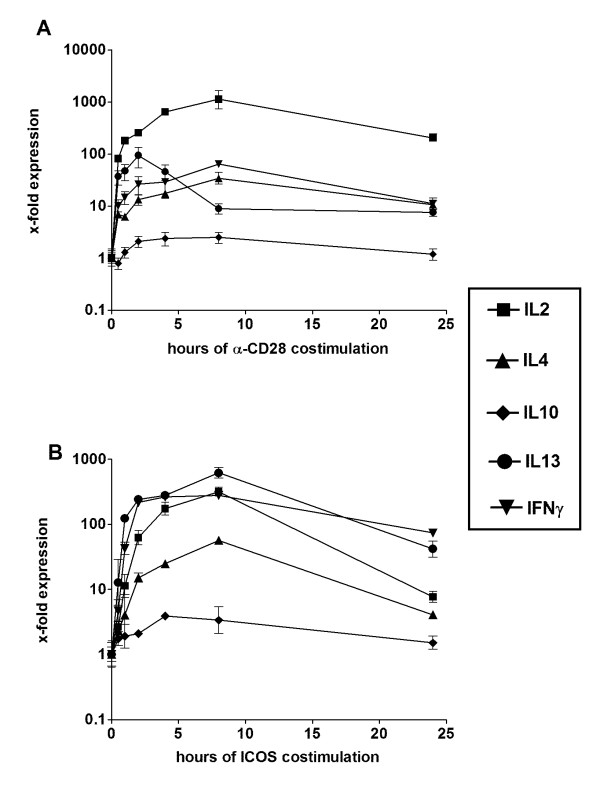
Time course of cytokine induction by costimulatory receptors. Human CD4+ T cells were stimulated by α-CD3/B7-2 (A) and α-CD3/B7-H2 (B) respectively and harvested after different time points. Cytokine mRNA level were determined using real-time RT-PCR. Levels were normalized to β-actin and unstimulated cells were set to 1. Each point and bar represents mean ± s.e.mean of duplicates measurements of one donor. Similar results were obtained from three independent donors.